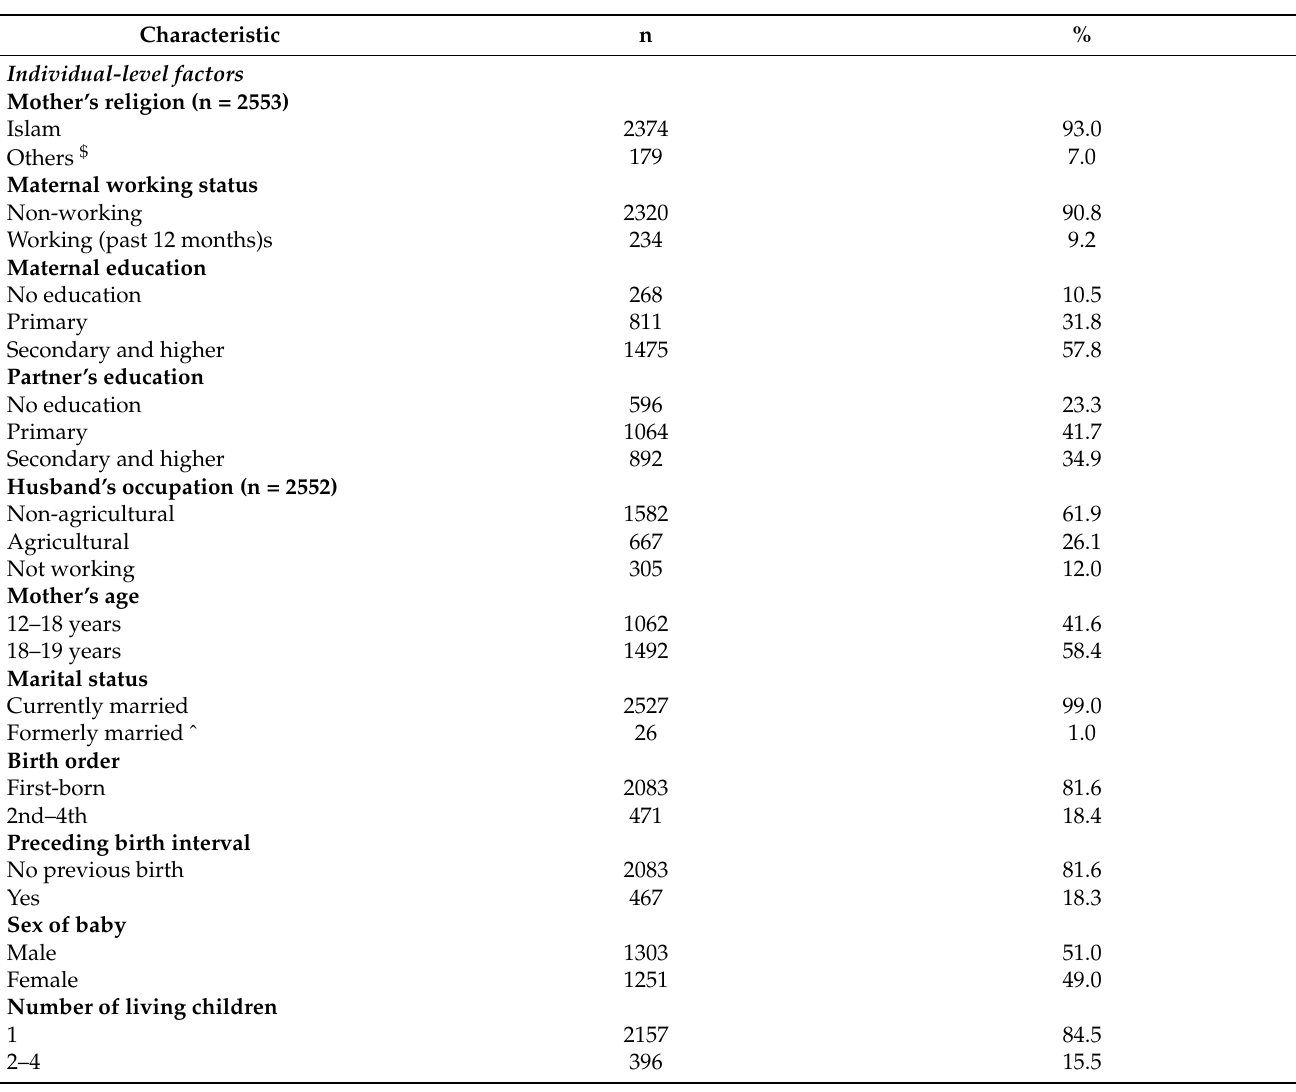
Table 1. Individual, exposure to media, household and community level characteristics of children 0–23 months of age, Bangladesh 2004–2014 (n =